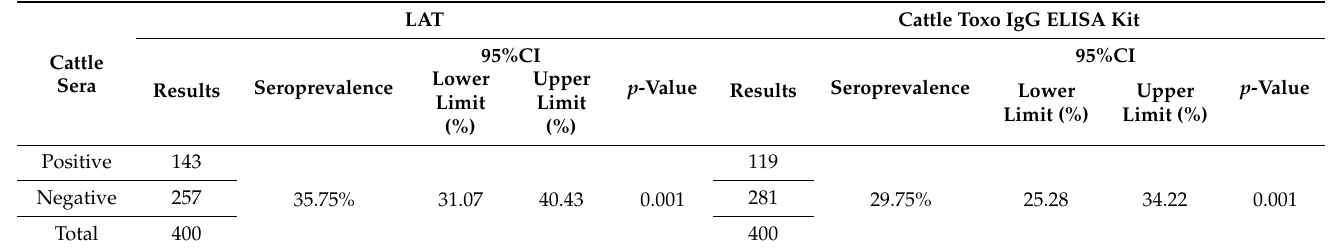
Table 2. Description of results from LAT and Cattle Toxo IgG ELISA kit for detection of anti- T. gondii IgG in 400 sera of